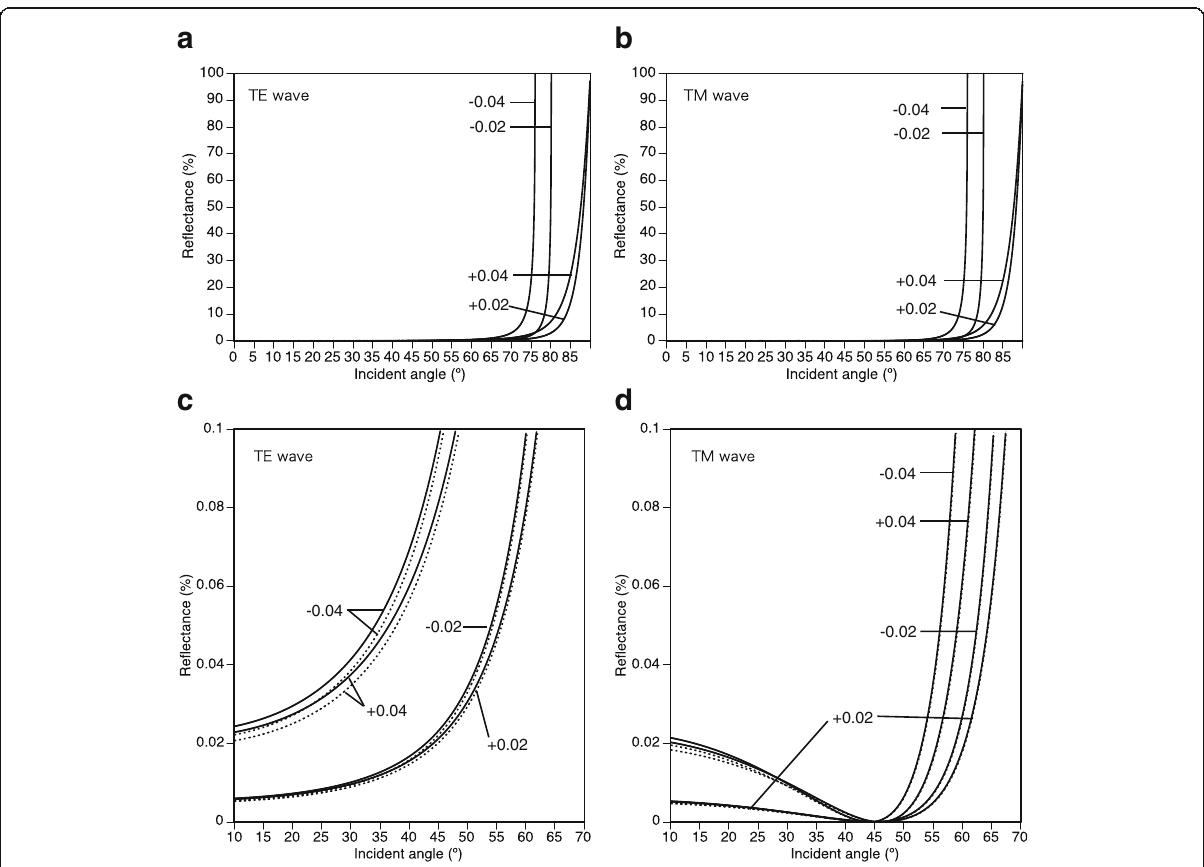
Fig. 5 Reflectance (%) of 633 nm light [TE wave ( a , c ) and TM wave ( b , d )] on the flat surface ( solid line ) and on the model of Thetys vagina tunic surface ( dotted line ). The difference in refractive index between the tunic and medium (seawater) were assumed to be − 0.04, − 0.02, 0.02, and 0.04. c and d show enlargements of a and b ,